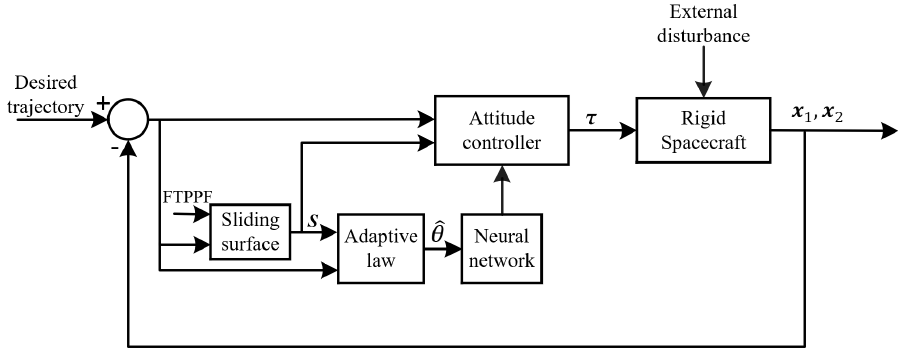
Figure 3. The diagram of the novel NN-based control for the rigid spacecraft attitude